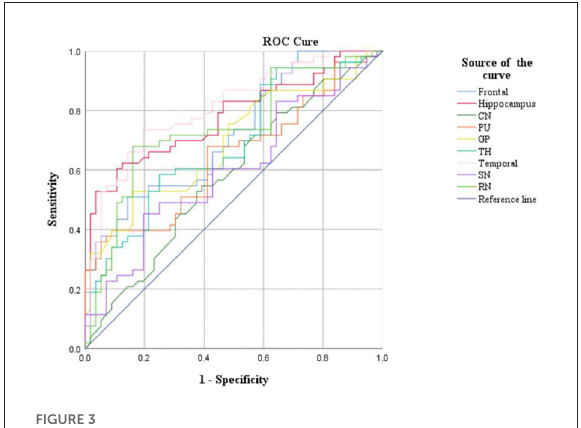
FIGURE3 ROC curve analysis results of CBF in brain